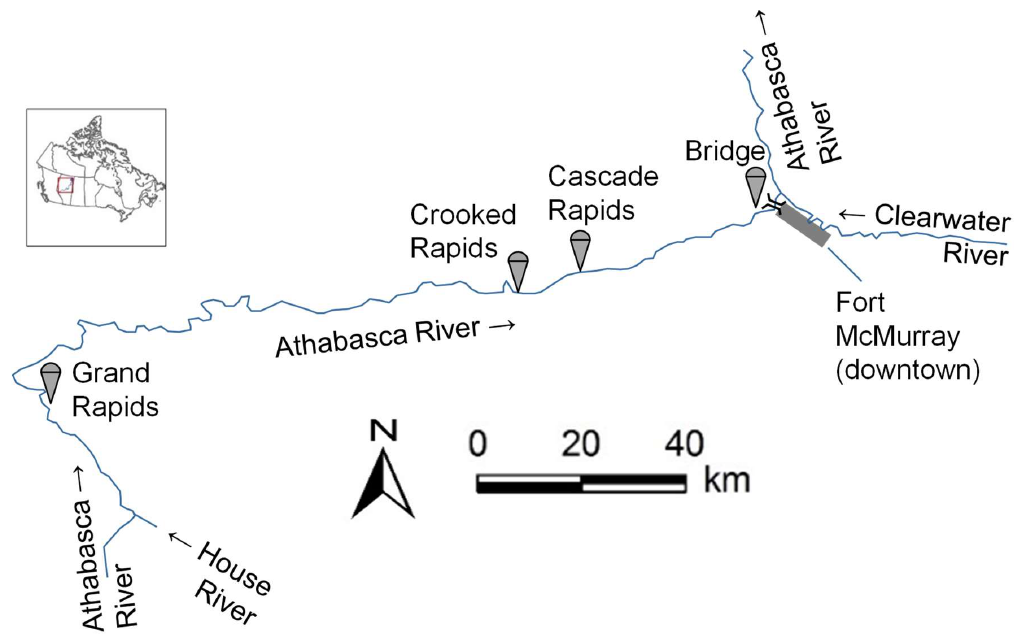
Figure 1. Athabasca River near Fort McMurray, Alberta.